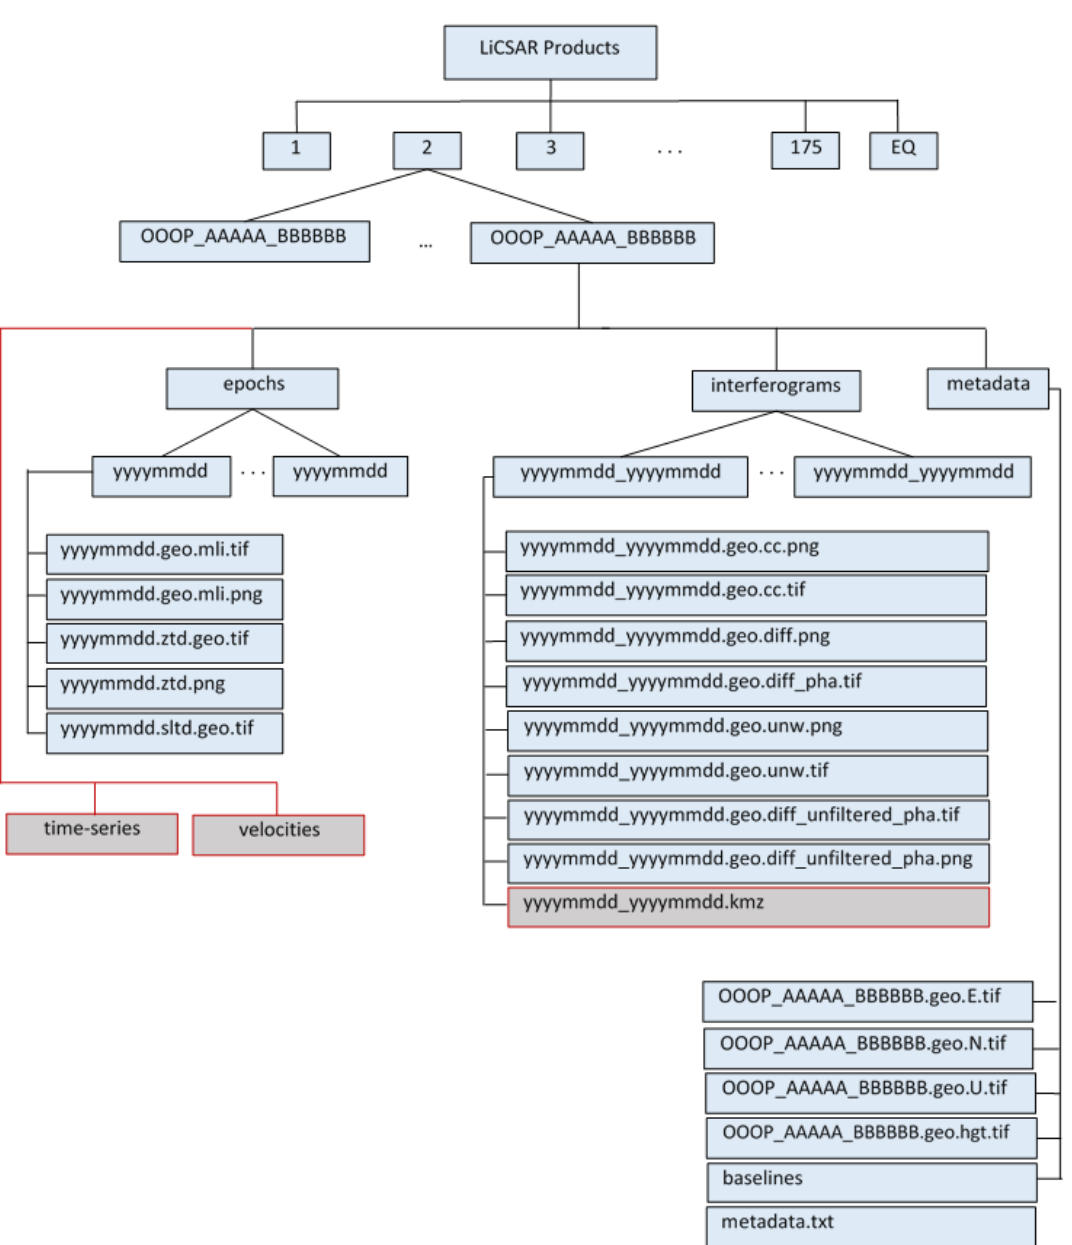
Figure 8. The file structure of the LiCSAR system products publicly available in COMET LiCS portal.